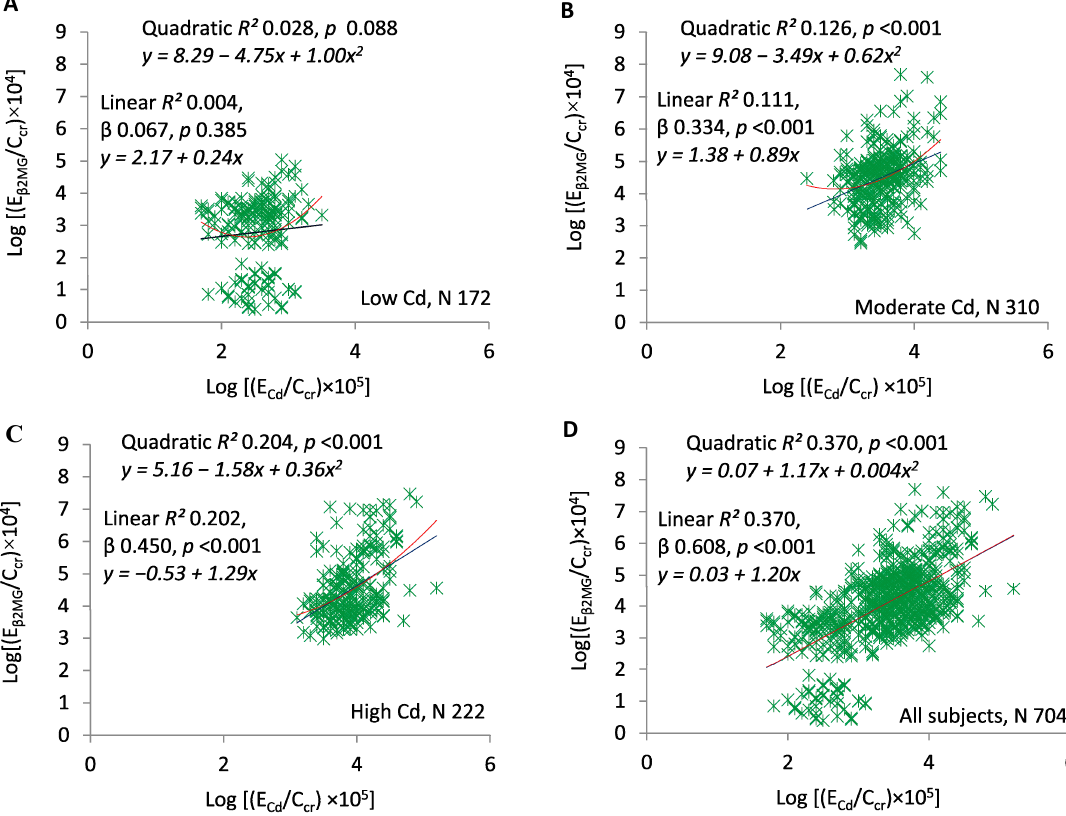
Figure 4. E Cd /C cr as a predictor of E β 2MG /C cr . Scatterplots compare log[(E β 2MG /C cr ) × 10 4 ] to log[(E Cd /C cr ) × 10 5 ] in subjects grouped by locality ( A – C ) and in all subjects ( D ). Quadratic and linear coefficients of determination ( R 2 ) are provided together with corresponding equations, standardized β coefficients, and p -values.